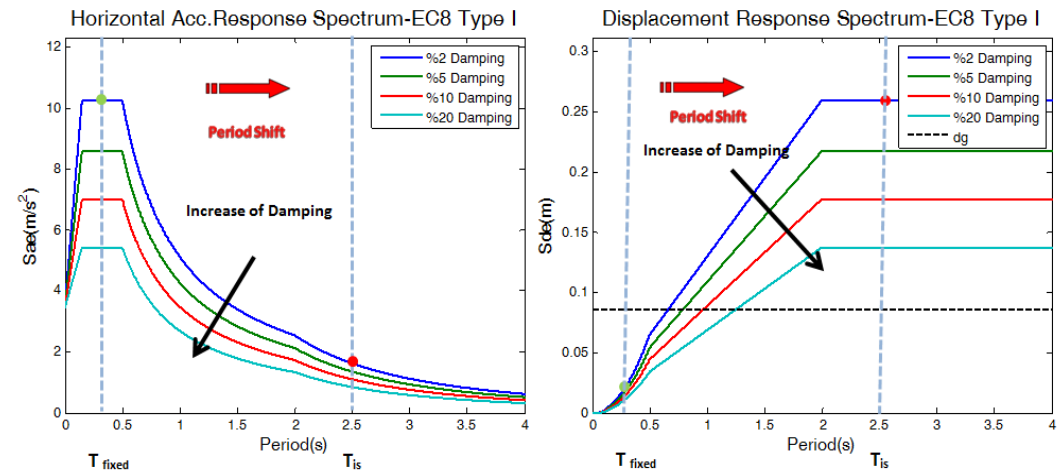
Figure 1. Benefits of seismic isolation based on the elongation of fundamental vibration period and supplemental damping [9,10].